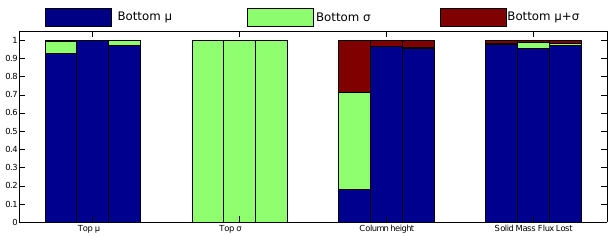
Figure 9. Sobol main sensitivity indices. For each of the four output parameters the three bars are for the different test cases: test case 1 on the left, test case 2 in the middle and test case 3 on the right. For each test case the different colors of the bars are for the different sensitivity indices: blue for first-order sensitivity index with respect to the bottom TGSD mean, green for the first-order sensitivity index with respect to the bottom TGSD standard deviation and brown for the second-order combined sensitivity